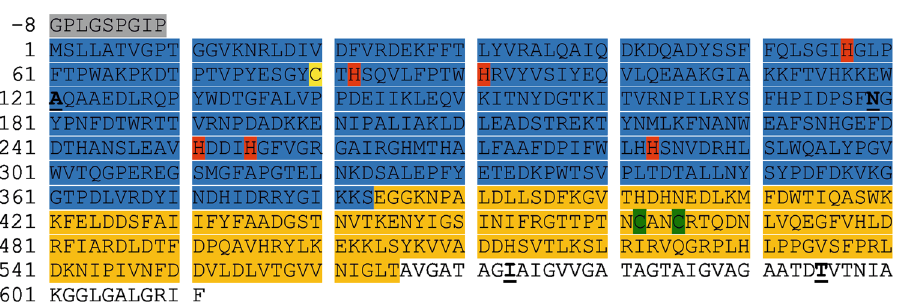
Figure 5. Sequence of the expressed Ab PPO4. shaded in grey: vector-derived sequence; blue: central domain up to serine 383, containing the copper-coordinating histidines (red); yellow: cysteine 80 which forms a thioetherbridge with histidine 82; orange: C-terminal domain up to T565 (C-terminus of the main expressed construct); green: CXXC-motif containing all the free cysteine residues of the enzyme; The four amino acid mutations relative to C7FF05 (Table 1) are underlined and marked in bold